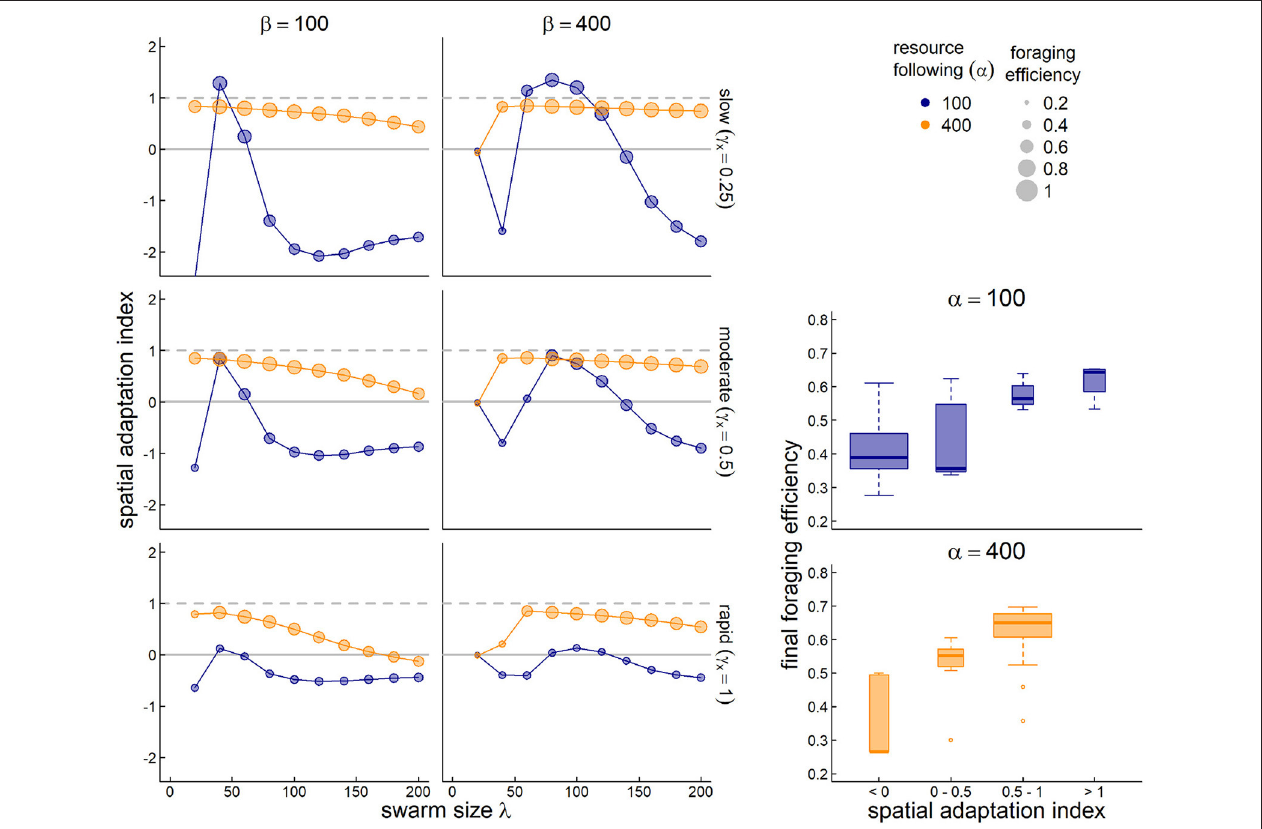
FIGURE 6 | Adaptation to a steadily drifting resource. In three scenarios, the spatial coordinates of the resource drift by 0.25, 0.5, and 1 unit per year (top to bottom, respectively). The y -axis is the spatial adaptation index (SA), i.e., the trend of the memory-driven migration divided by the resource drift trend. Values near 1 indicate a behavior that keeps up with climate change, values near 0 indicate no change in migration behavior, and negative values indicate a trend that is opposite to the climate trend. We compare across spatial scales of sociality ( λ – x -axis), for low and high values resource following ( α 400 and 100–orange and blue dots) and low and high = values of sociality ( β 100 and 400, left and right panels). The size of the circles is proportional to the foraging efficiency of the resulting parameter combinations. The = bottom-right boxplots indicate the final year foraging efficiency against SA; purple and blue boxes indicate the highest values, orange and gray lower